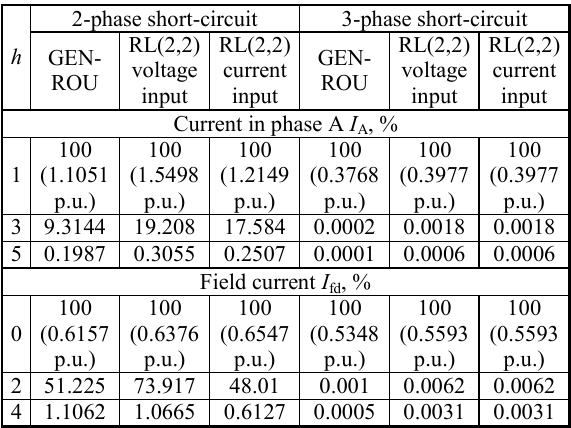
Fig. 2. Envelopes of the current in phase A for 2-phase short- circuit to earth (a) and 3-phase short-circuit (b)